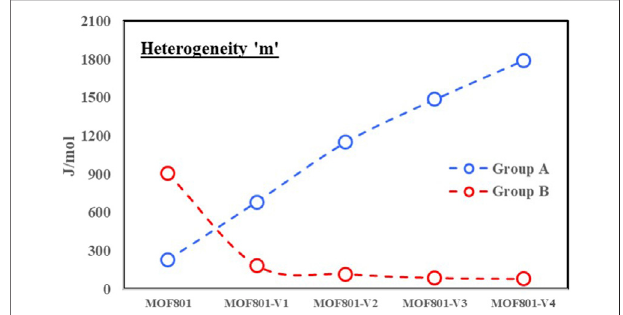
FIGURE 4 | Variations in the surface heterogeneity of MOF 801 and